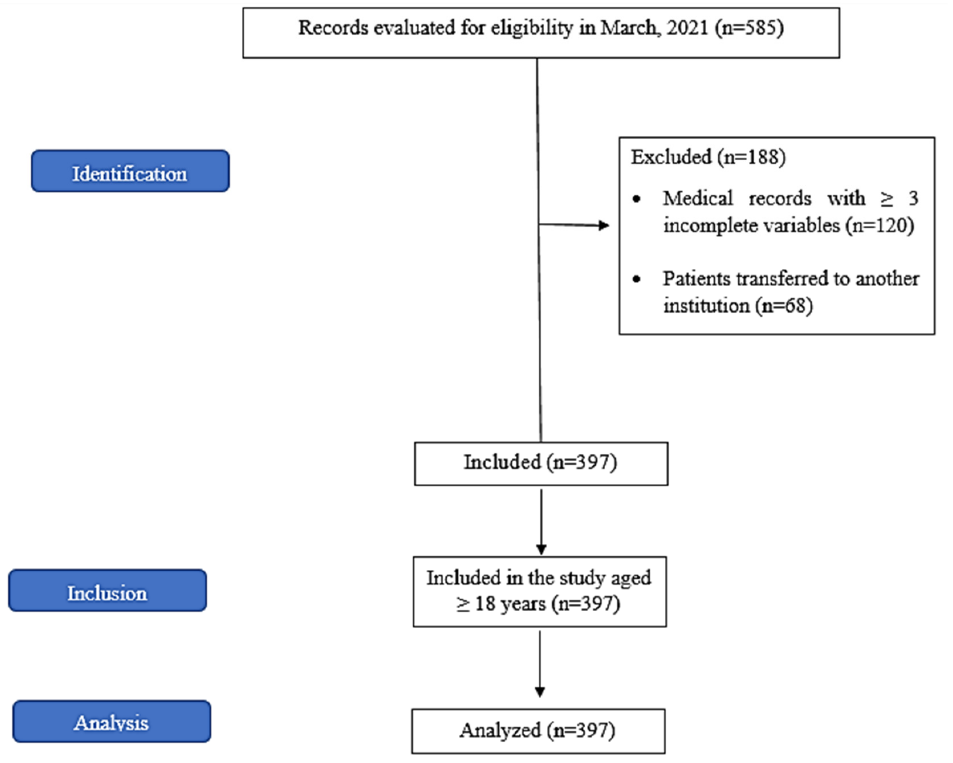
Figure 1. Study conduction flowchart according to the Strengthening the Reporting of Observational Studies in Epidemiology (STROBE) guidelines.